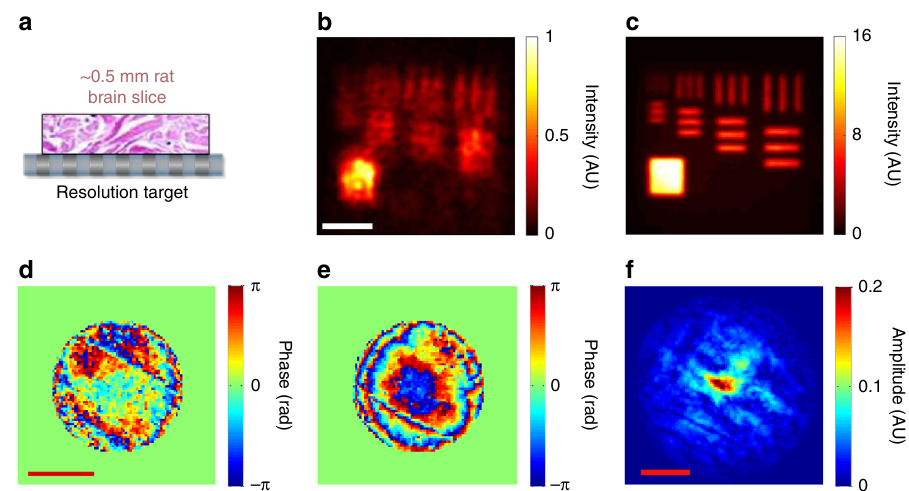
Fig. 4 Experimental demonstration of aberration correction for a target underneath a rat brain tissue. a Layout of the sample geometry. A thick rat brain tissue slice was placed on the top of the resolution target. b , c CLASS images of a resolution target under a 500 μ m-thick rat brain tissue layer before and after aberration correction, respectively. Scale bar, 4 μ m. Color bars, intensity normalized by the maximum intensity in ( b , d and e ) Input and output phase correction maps, respectively. Scale bar, k 0 α . Color bars, phase in radians. f Amplitude transfer function calculated by cross-correlation between ( d , e